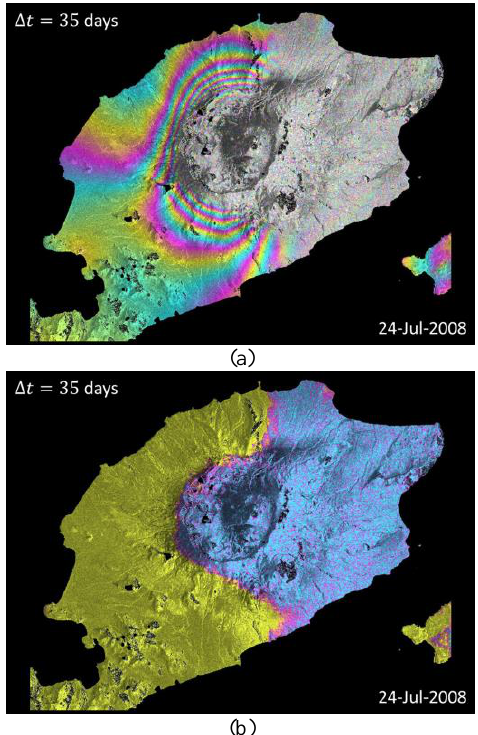
Figure 6. Surface deformation and surface change that occurred within the first few days of Okmok’s eruptive period in 2008. (a) Surface deformation accumulated within the first 12 days of the eruptive period. Associated surface change induced by ash fall and deposition of eruptive